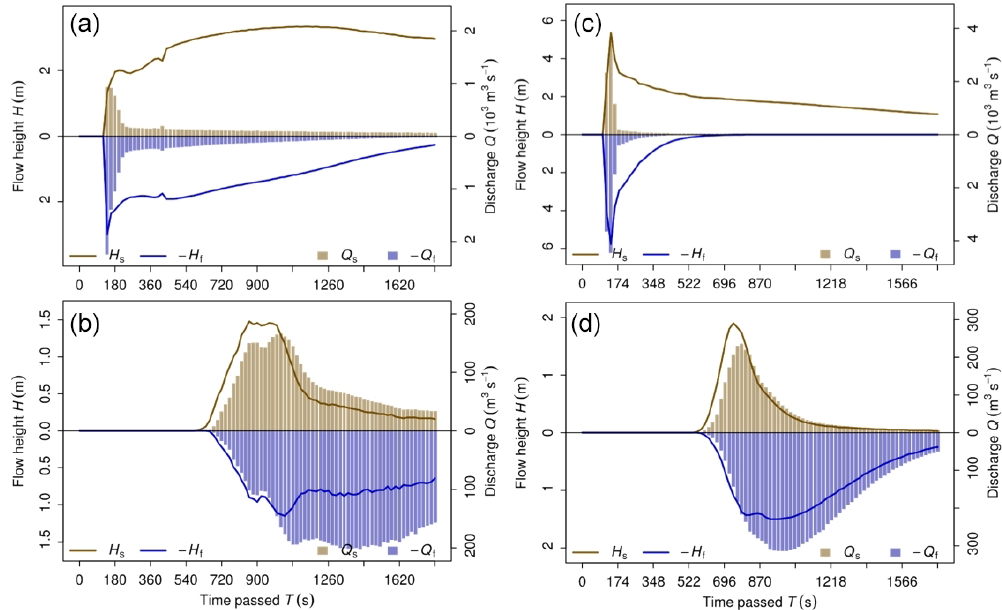
Figure 9. Output hydrographs OH2 and OH4 derived for the scenarios S1 and S2. (a) OH2 for Scenario S1. (b) OH4 for Scenario S1. (c) OH2 for Scenario S2. (d) OH4 for Scenario S2. See Figs. 7 and 8 for the locations of the hydrograph profiles O2 and O4. H s is solid flow height, H f is fluid flow height, Q s is solid discharge, and Q f is fluid discharge.